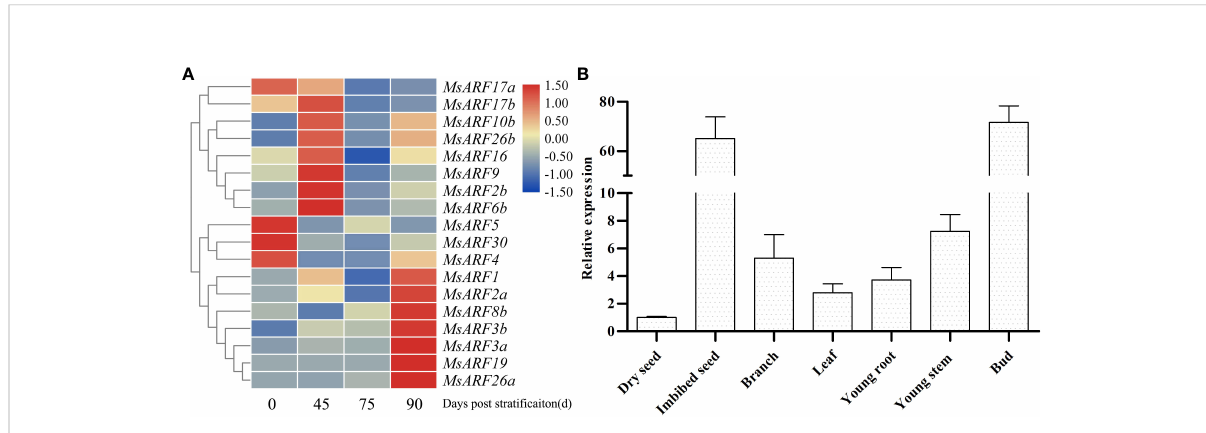
FIGURE 2 Gene expression analysis of MsARFs . (A) Expression of 25 MsARFs during seed germination. (B) Expression of MsARF5 in various